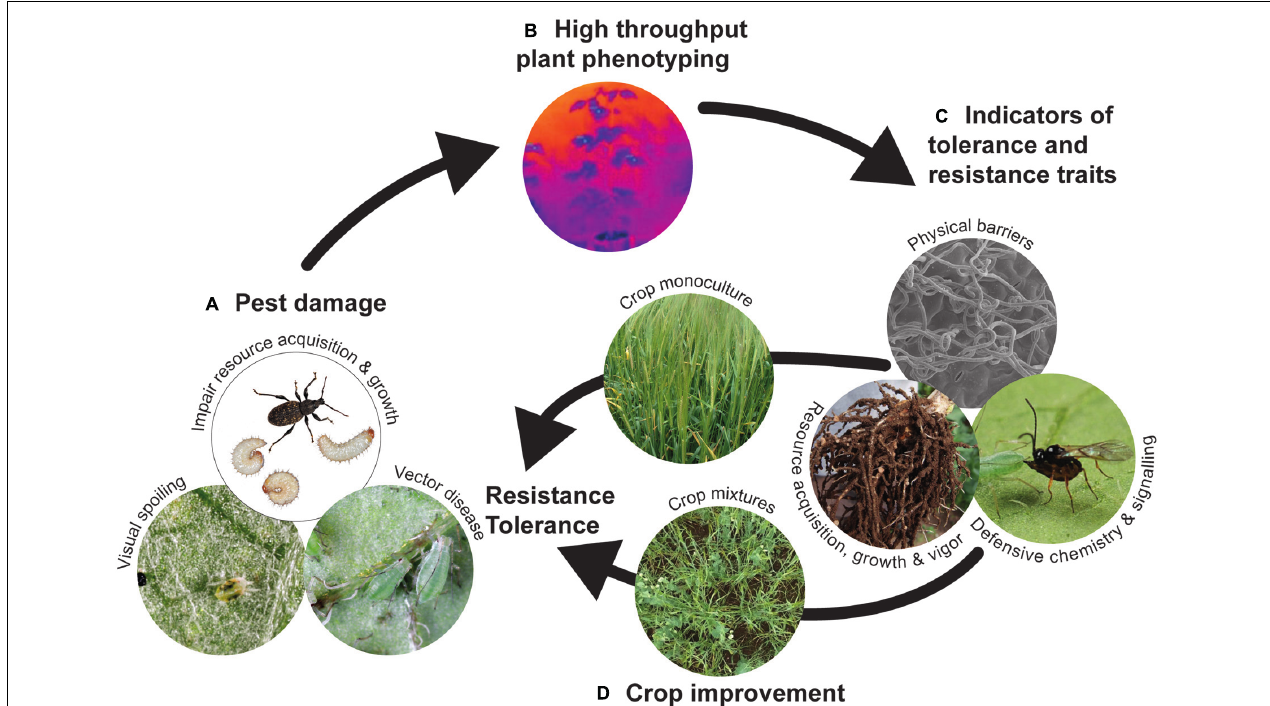
FIGURE 1 | Proposed strategy for improving crop protection against target arthropod pests. (A) Identify the appropriate defense strategy (resistance or tolerance) depending on the type of damage and threat posed by the target pest; (B) develop high throughput phenotyping (HTP) technologies, particularly new imaging methods, for screening large plant populations to (C) identify appropriate indicators of resistance and tolerance traits; indicators could include reflectance properties that provide information about leaf surface characteristics and physical barriers, thermal and absorption data that provides information about stomatal conductance and water status, and therefore indicate photosynthetic activity and plant vigor, and absorption/reflectance data that characterizes leaf pigment composition and metabolic changes underpinning defense signaling (e.g., attracting natural enemies); (D) traditionally, desirable traits are characterized in germplasm monocultures, but phenotyping traits for use in crop mixtures is a potential route for durable pest control, particularly under environmental